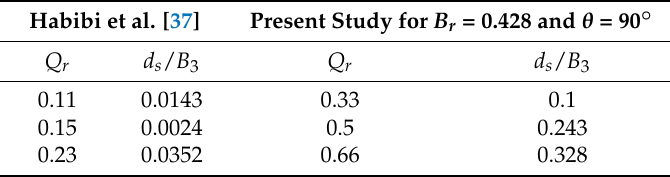
Table 7. Comparison between the current study and the results from Habibi et al. [37]. Habibi et al.